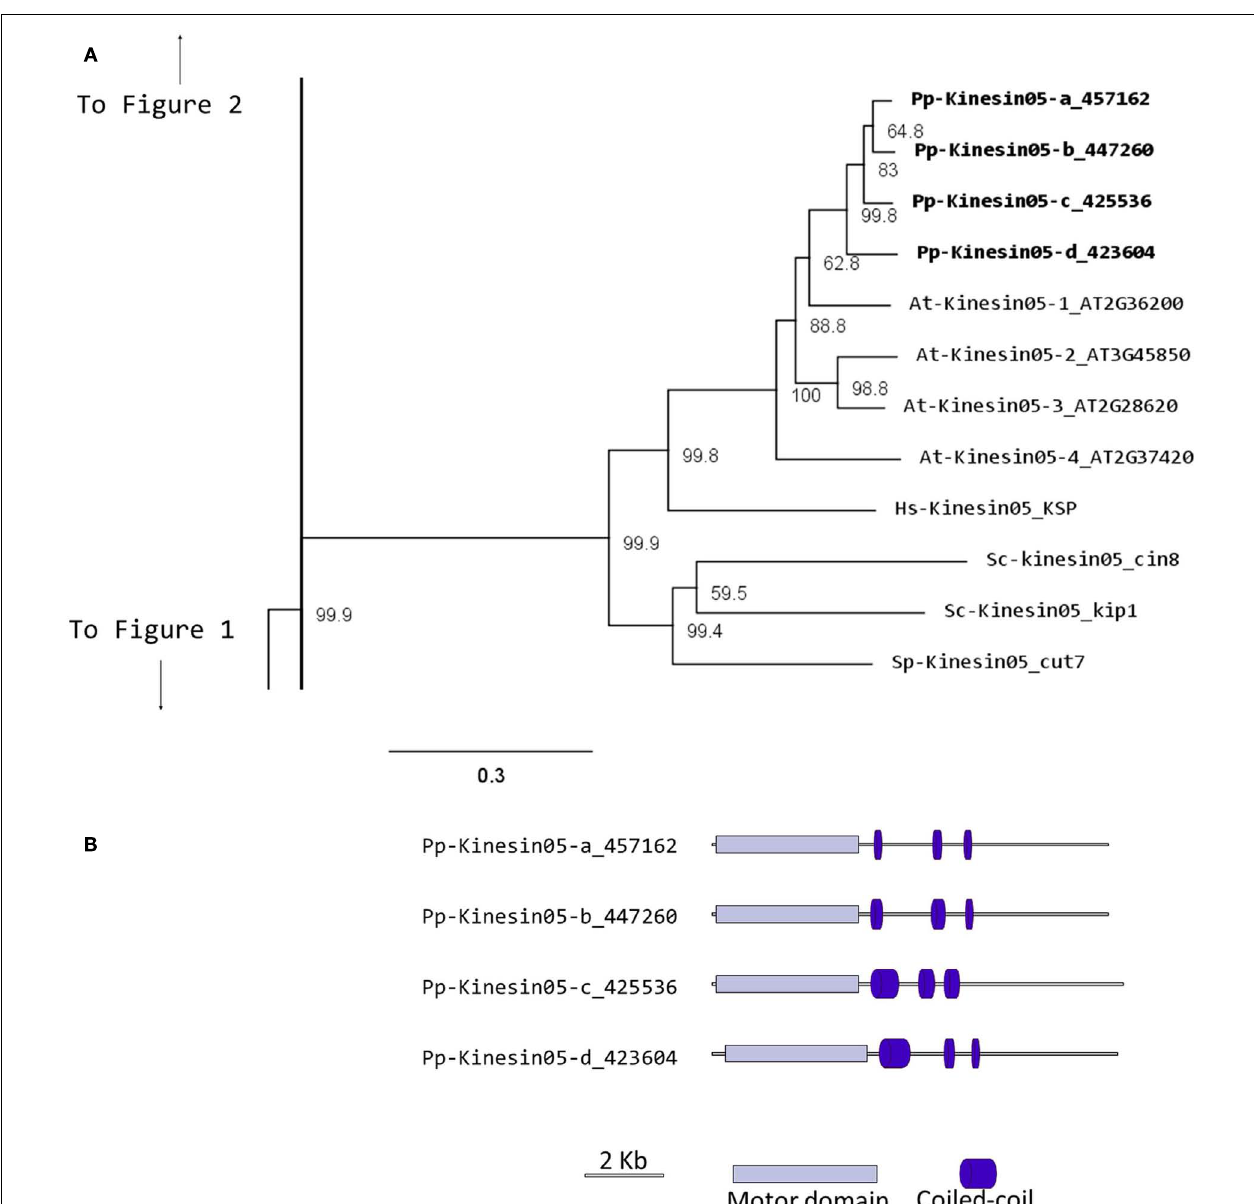
branch length corresponding to the number of substitutions per site. The Physcomitrella numbers correspond to the Phypa number uniquely associated with each gene model (version 1.6) at cosmoss.org. (B) Gene models of kinesin 5s. Schematic diagrams showing the structure and domain architecture of kinesin 5s. Domains are indicated at the bottom of the